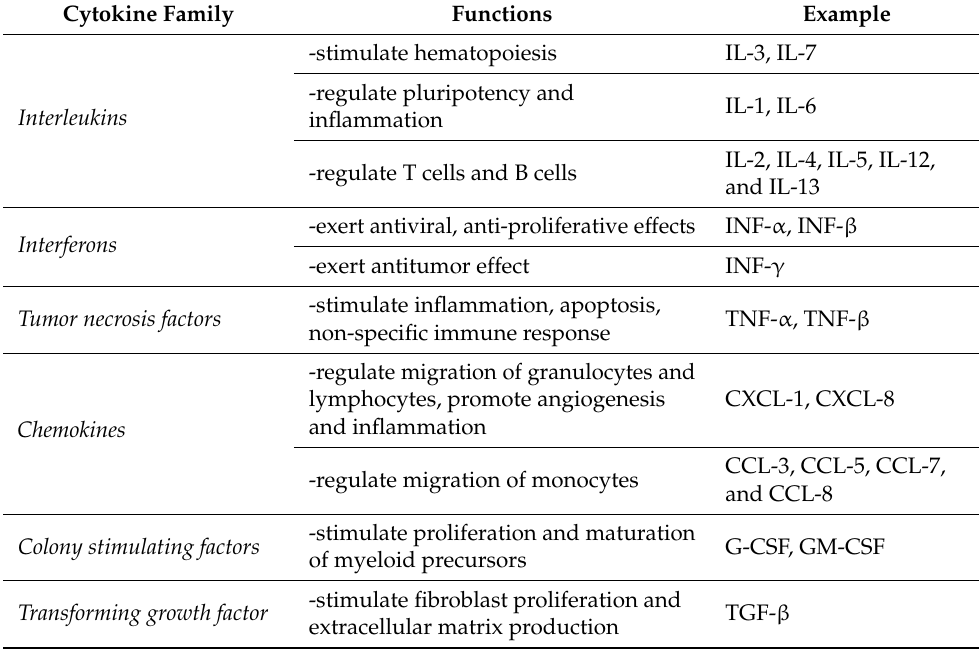
Table 1. Classification of cytokines based on structure and function subgroups (modified from